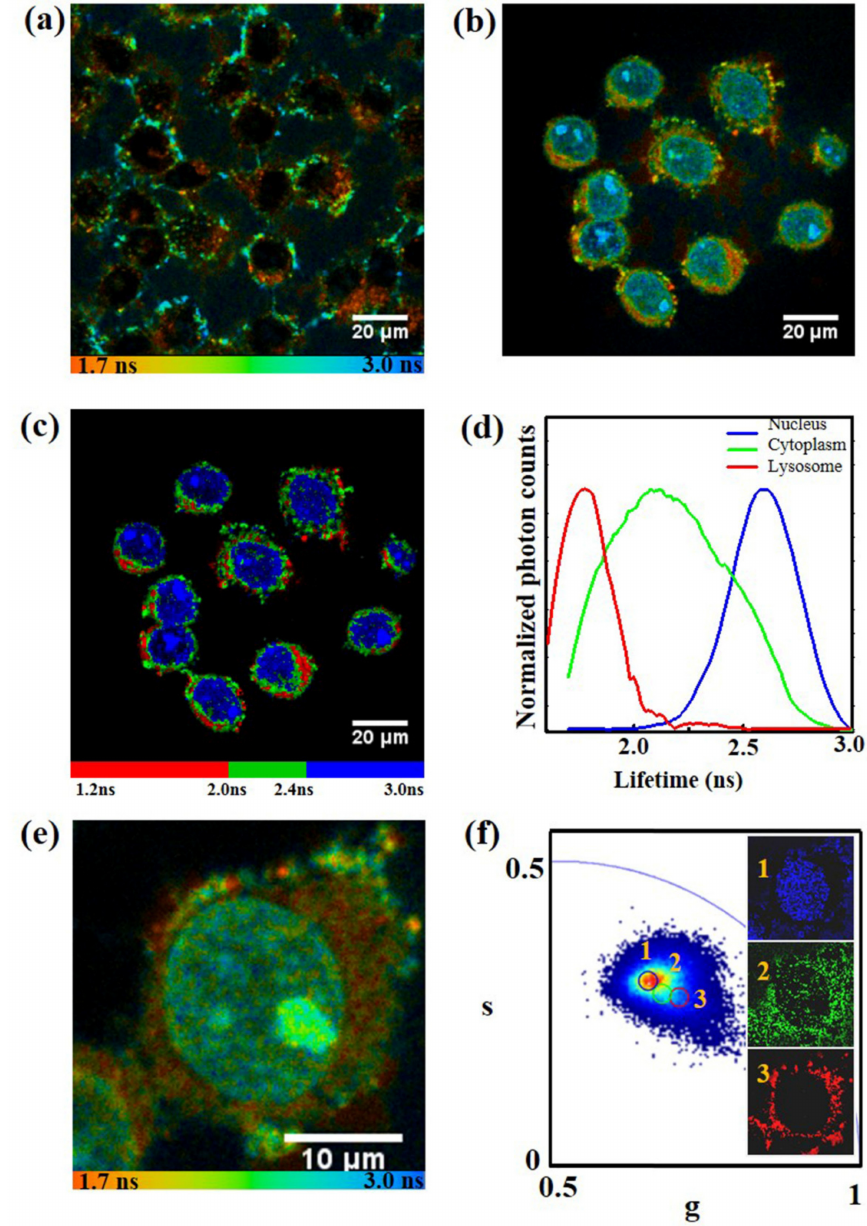
Figure 4. The FLIM images of the CDs in the HeLa cells were compared. ( a ) Cells incubated with CDs for 2 h. ( b ) Cells incubated with CDs for 2 h, and then cultured with digitonin for 3 min for cell permeabilization (scale bar: 20 µ m). ( c ) The di ff erent fluorescence lifetimes of CDs in the lysosomes, cytoplasm, and nucleus of the cell in discrete colors. ( d ) Statistical curves of the CDs fluorescence lifetime distribution in di ff erent regions of the cell (lysosomes, cytoplasm, and nucleus). ( e ) FLIM images of a permeabilized cell and ( f ) the corresponding phasor FLIM distribution, where 1, 2, and 3 correspond to the three regions of the nucleus, cytoplasm, and lysosomes,